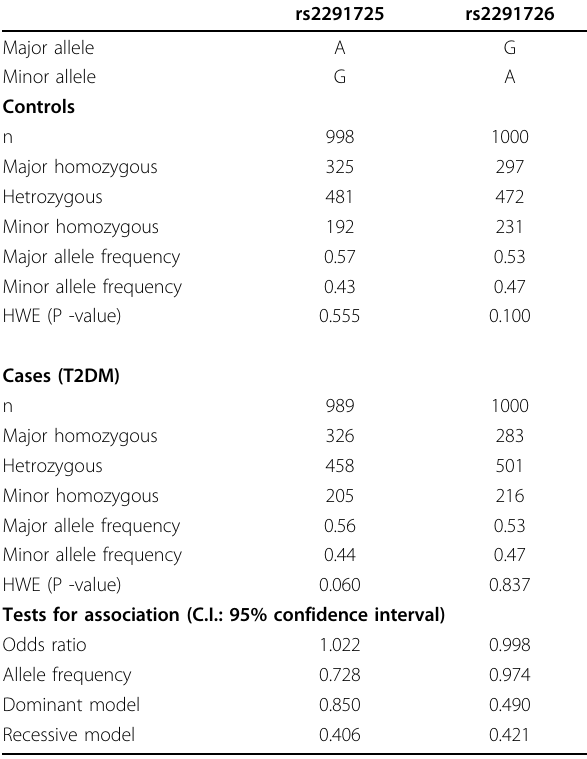
Table 2 Association analysis of GIP SNPs with Type 2